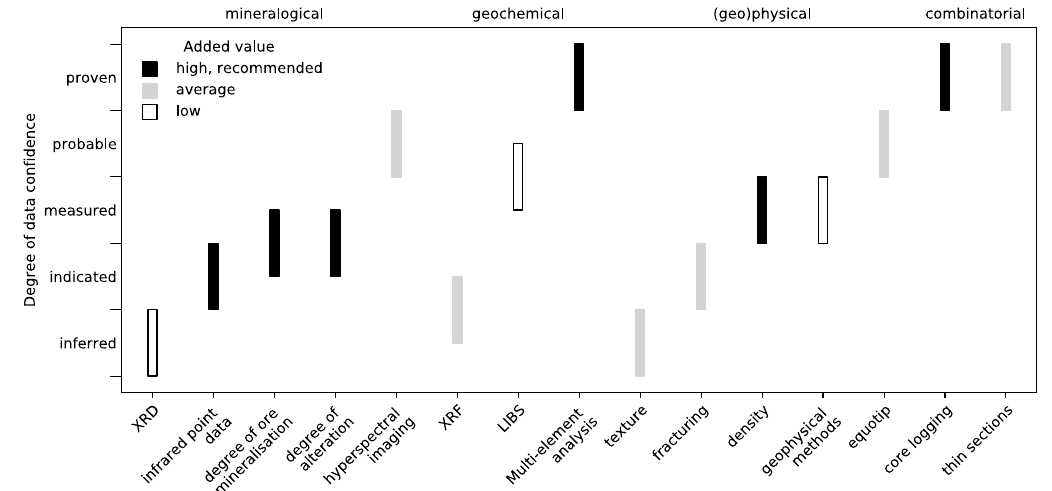
Figure 4. Indicative ranges of dataset-specific confidence in the quality, quantitative nature, robustness, and representativity. The box colour is based on added value to the fingerprint classification.